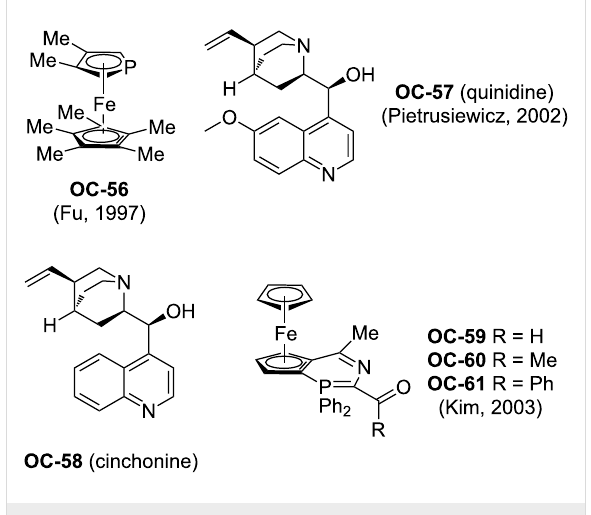
Figure 12: Early organocatalysts for enantioselective desymmetriza- tion of meso